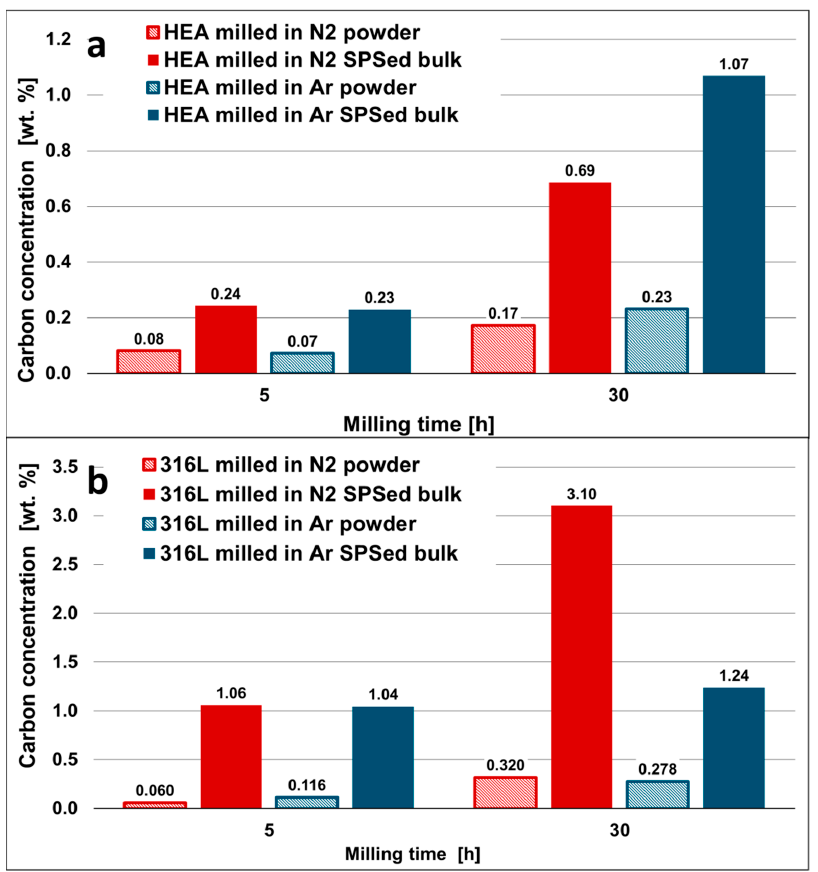
Figure 4. Carbon concentration of selected powders milled in Ar and N 2 atmosphere as compared to concentration of the same materials after the SPS process (SPSed bulks); ( a ) HEA and ( b ) 316 steel. The SPS densification in graphite die significantly increases carbon contamination .